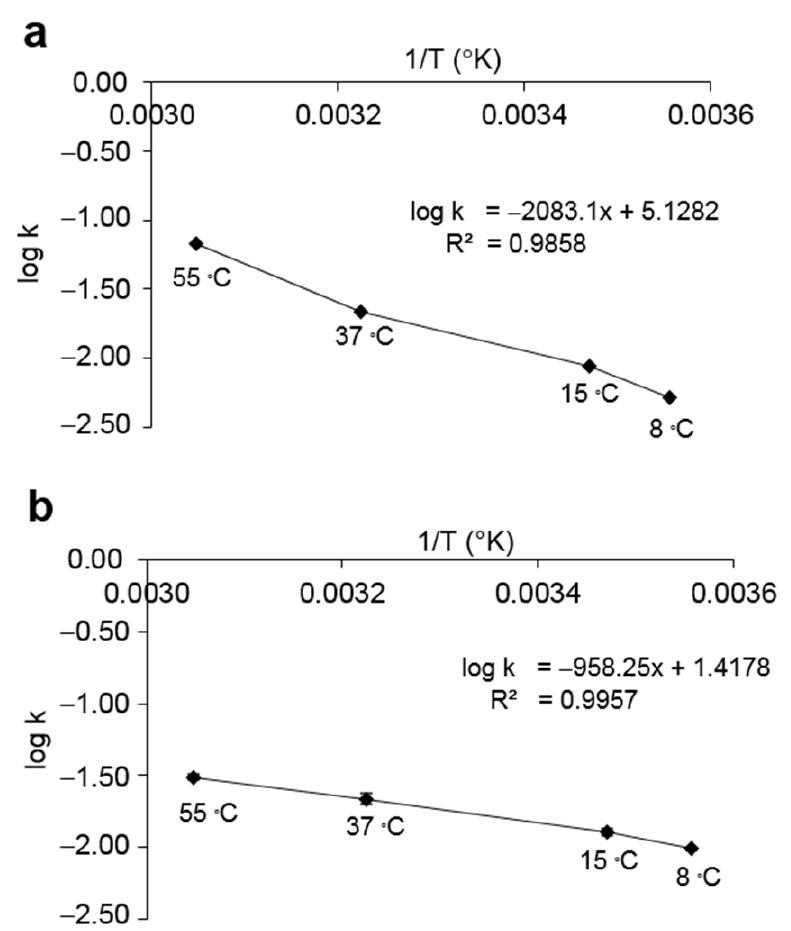
Figure 8. Arrhenius plots of the logarithms of the specific rates thermal degradation of the freeze- dried spores of L. fusiformis 5.1 ( a ) and L. xylanilyticus ( b ) after storage at 8, 15, 37 and 55 ◦ C for 30